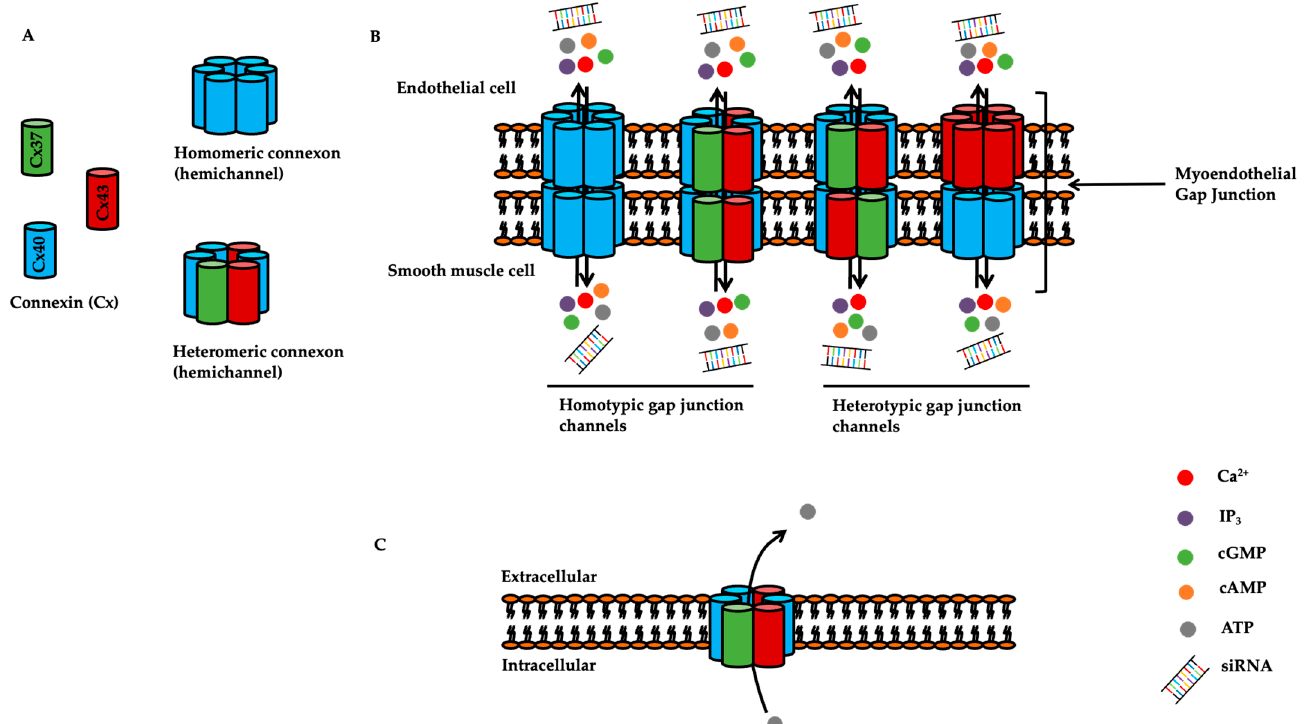
Figure 1. Structure of hemi-channels and gap junctions. ( A ) Six connexins assemble to form a ho- momeric or heteromeric connexon (also known as hemi-channel). ( B ) Two connexons from adjacent cells dock with each other to form a gap junction (homotypic or heterotypic) which allows the ex- change of molecules less than 1 kD in molecular weight such as Ca 2+ (calcium), IP 3 (inositol triphos- phate), cGMP (cyclic guanosine monophosphate), cAMP (cyclic adenosine monophosphate), ATP (adenosine triphosphate) and siRNA (small interfering RNA). ( C ) The connexon can also permit the release of molecules such as ATP (adenosine triphosphate) from the intracellular to the extracellular space.